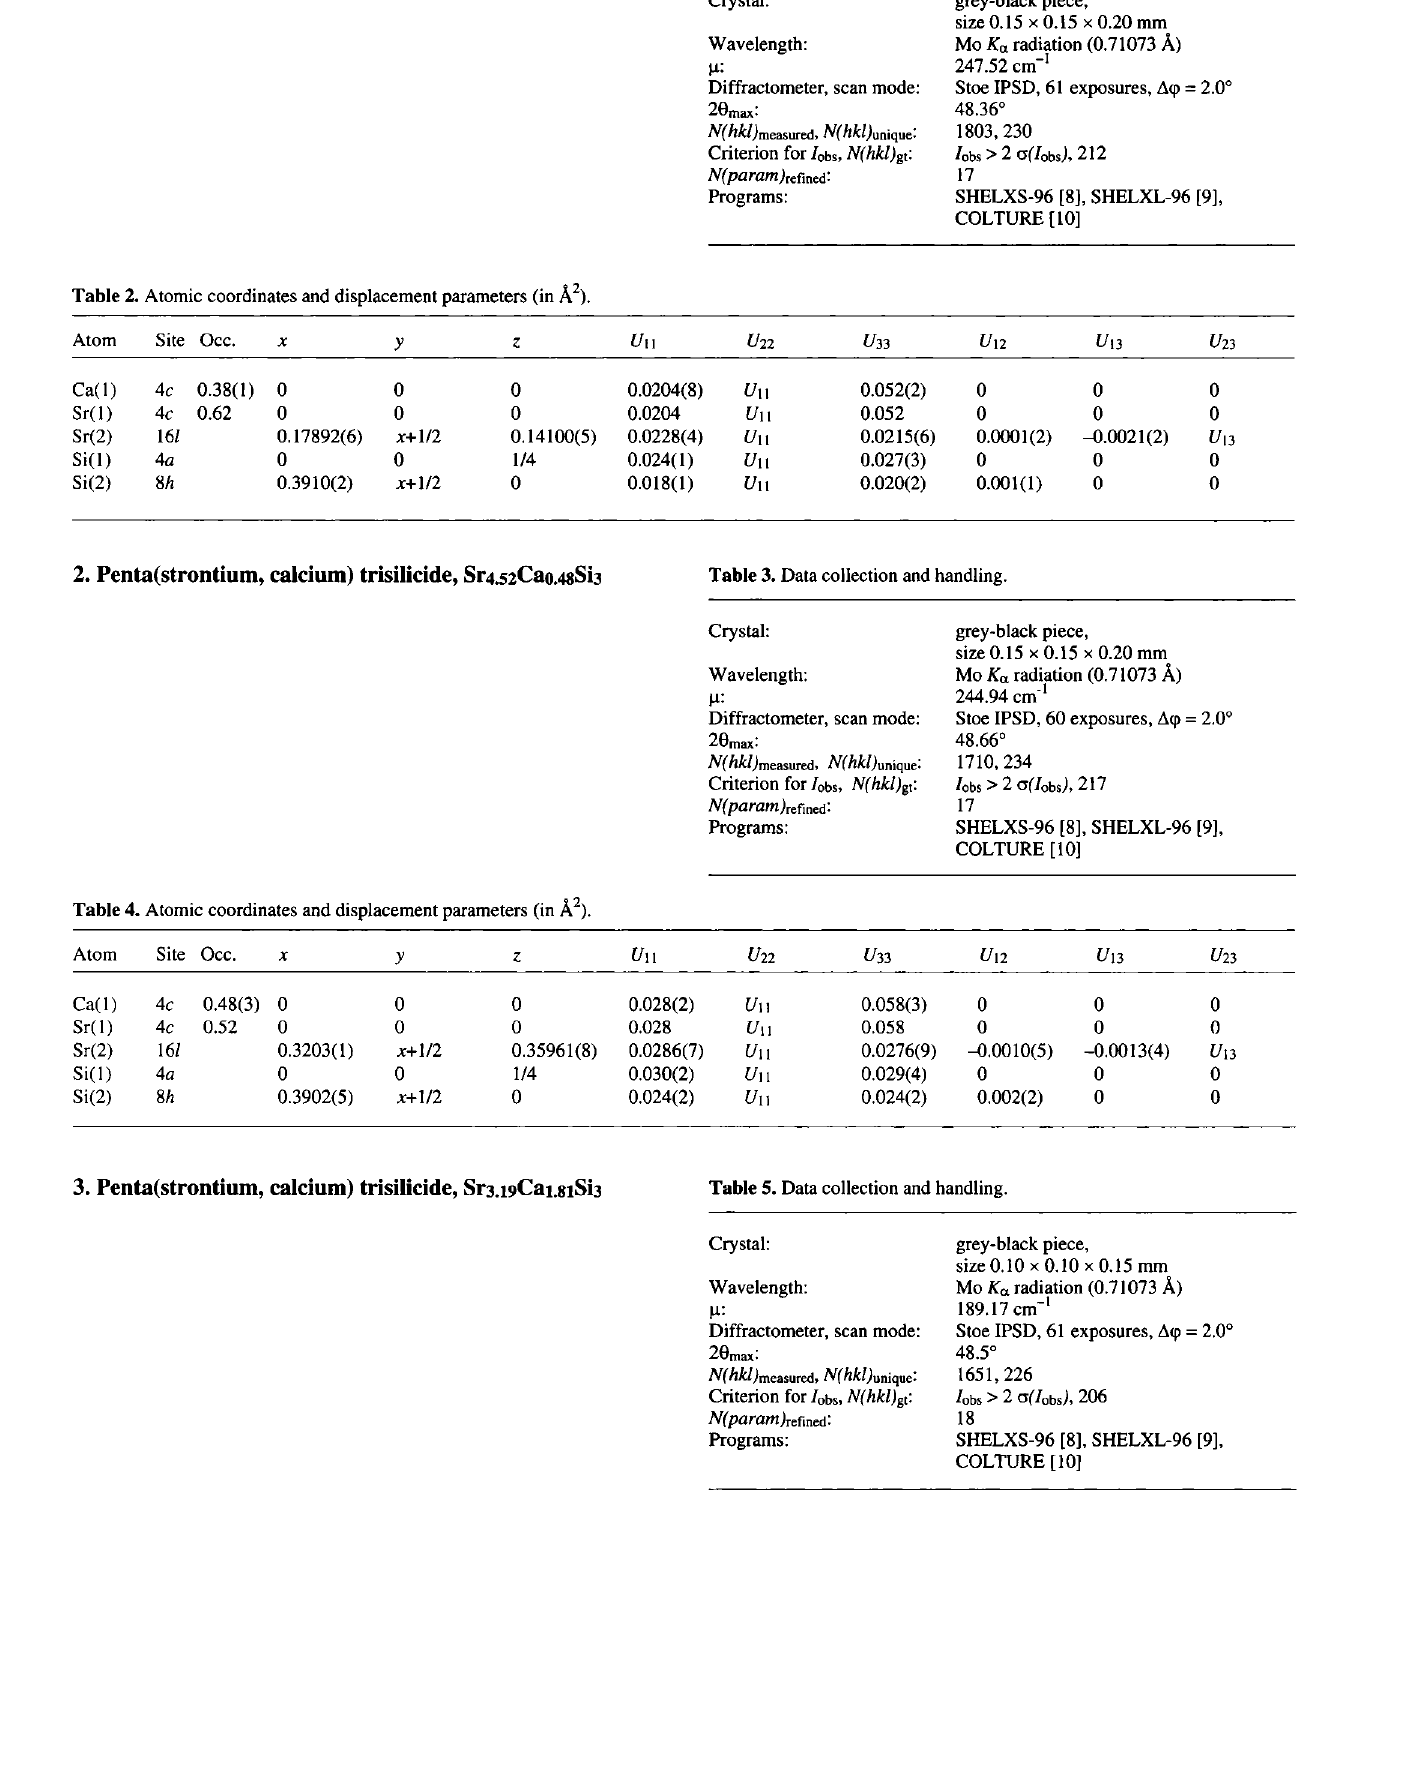
Table 2. Atomic coordinates and displacement parameters (in Ä 2 ). Atom Site Occ.